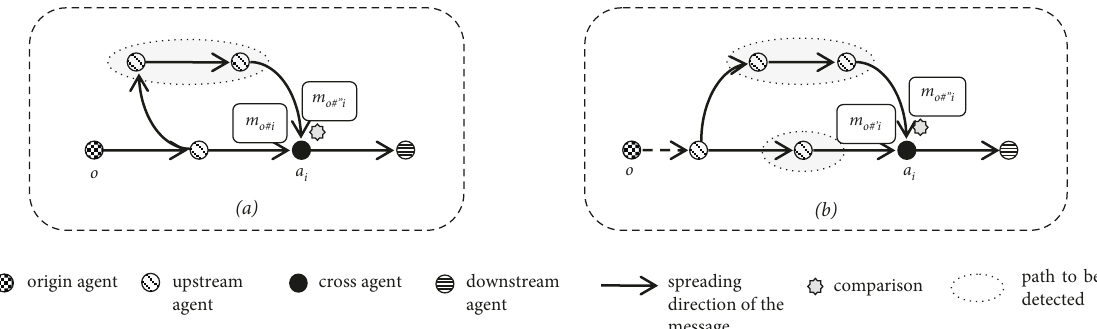
Figure 3: Example for feed-forward path reputation